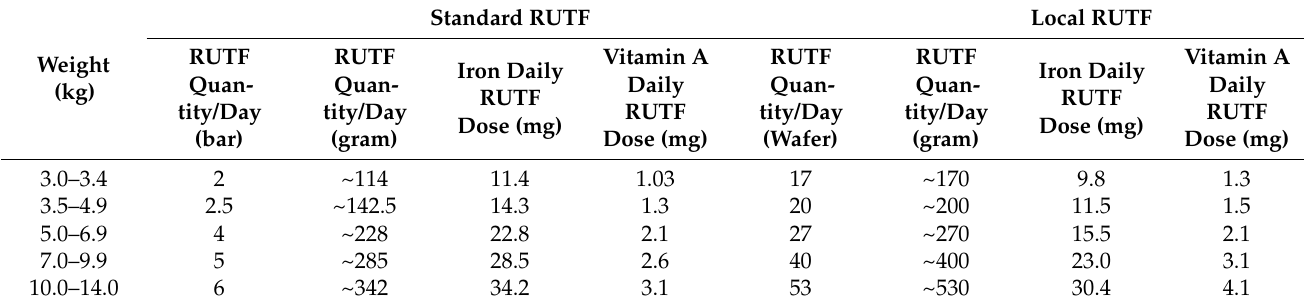
Table 2. Daily food ration and iron and vitamin A content per RUTF by child’s